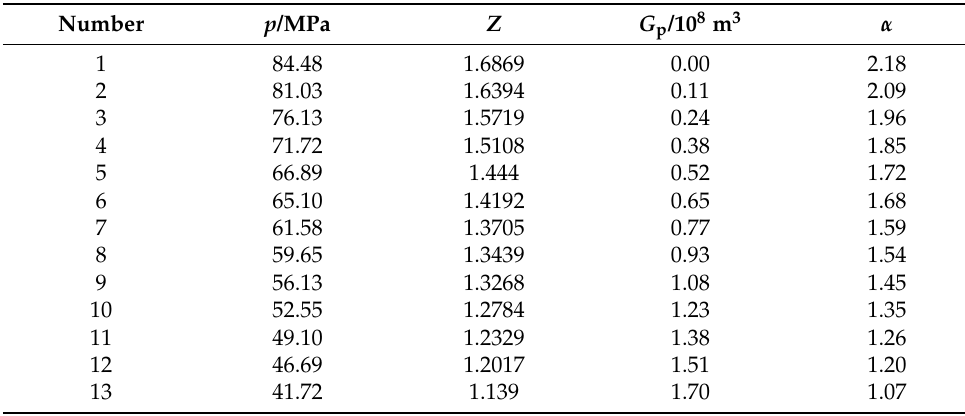
Table A4. Historical production data of the GOM reservoir [33].